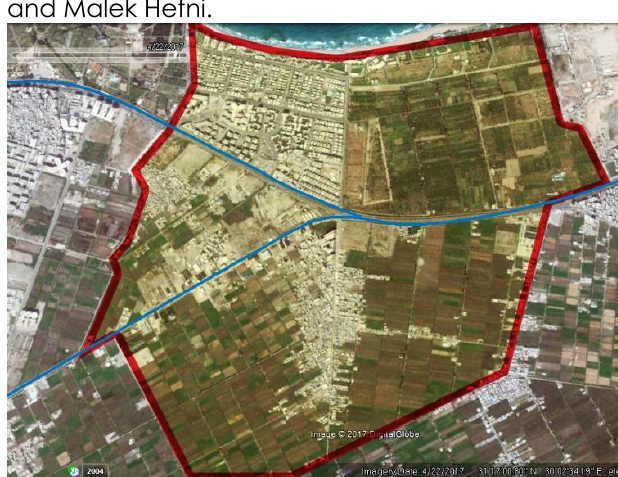
Figure 6: Focus Zone in Al-Maamoura - Source: Google